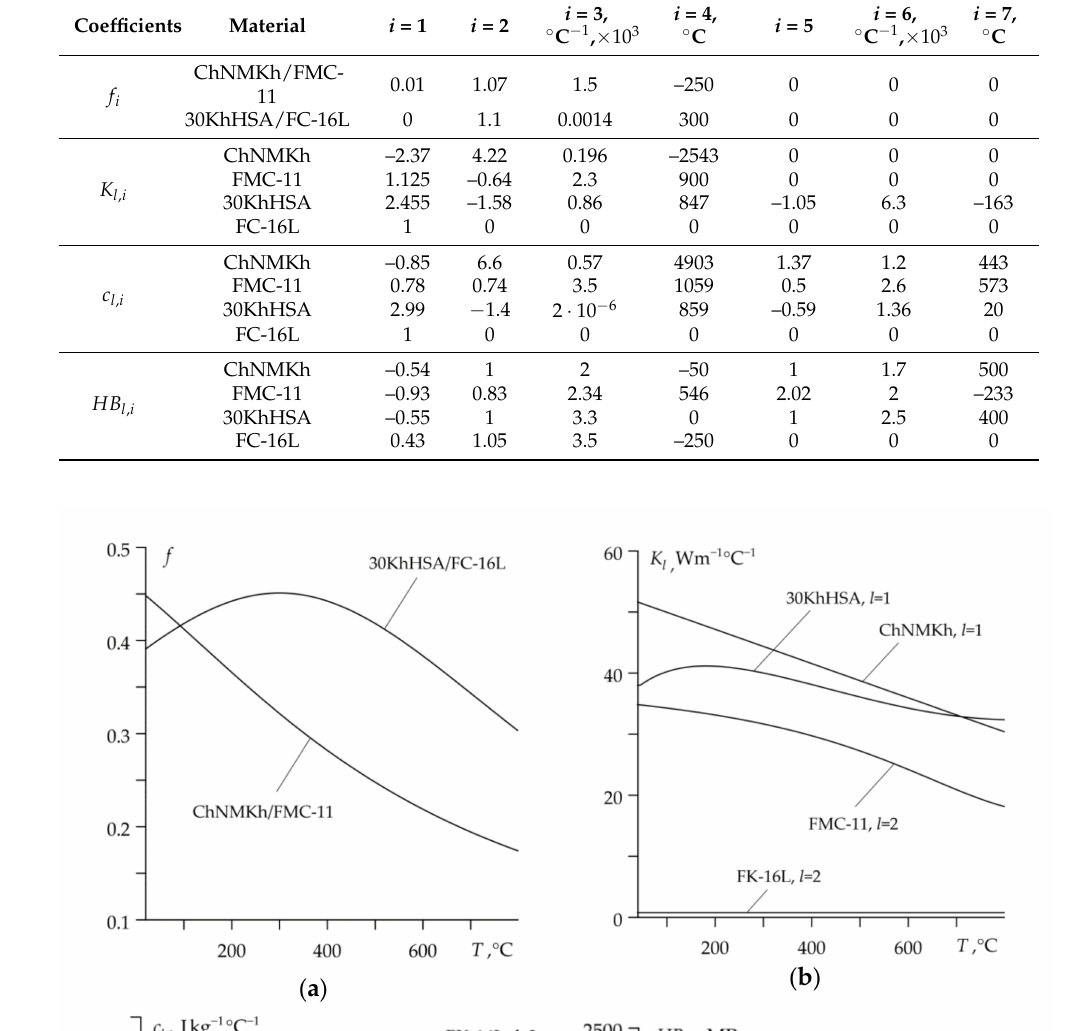
Table 2. Coefficients in approximation functions (4)–(6) and (8) for considered materials [31].